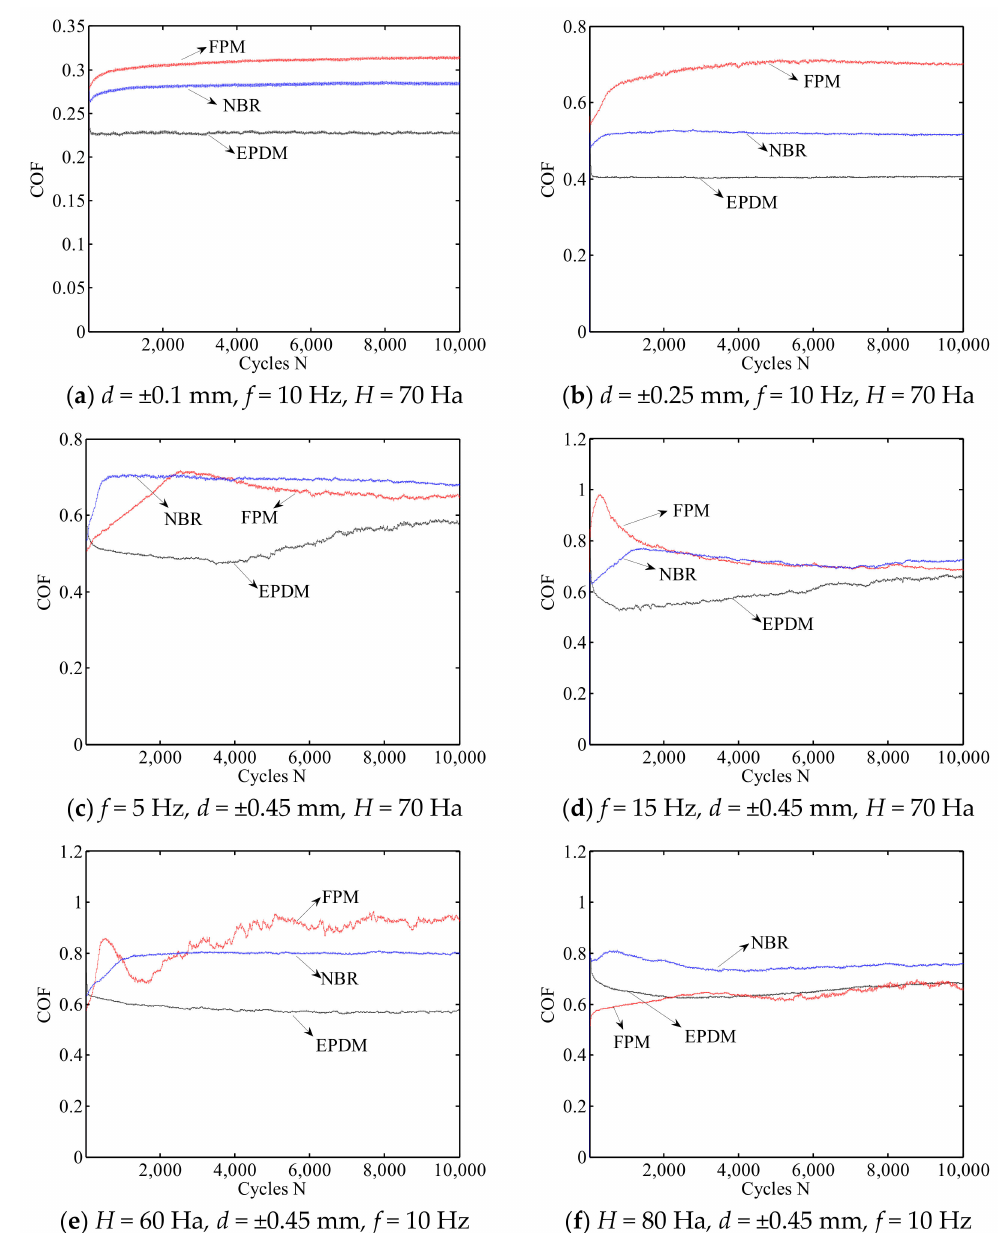
Figure 8. The friction coefficient curve of three rubbers under F n = 5 N. Figure 8e,f show the friction coefficient curve of three rubbers for different